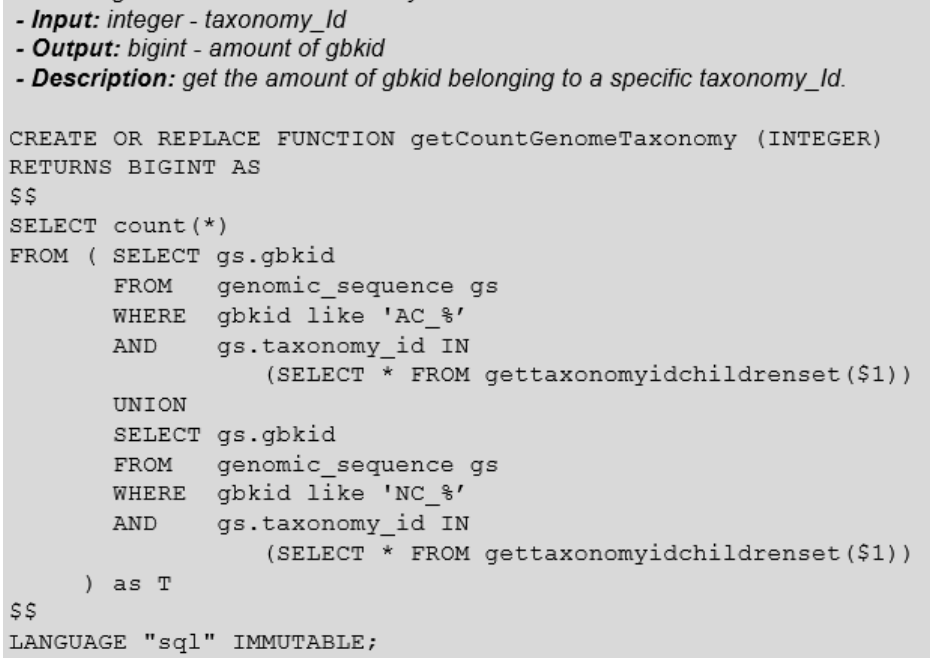
Figure 10. Function: